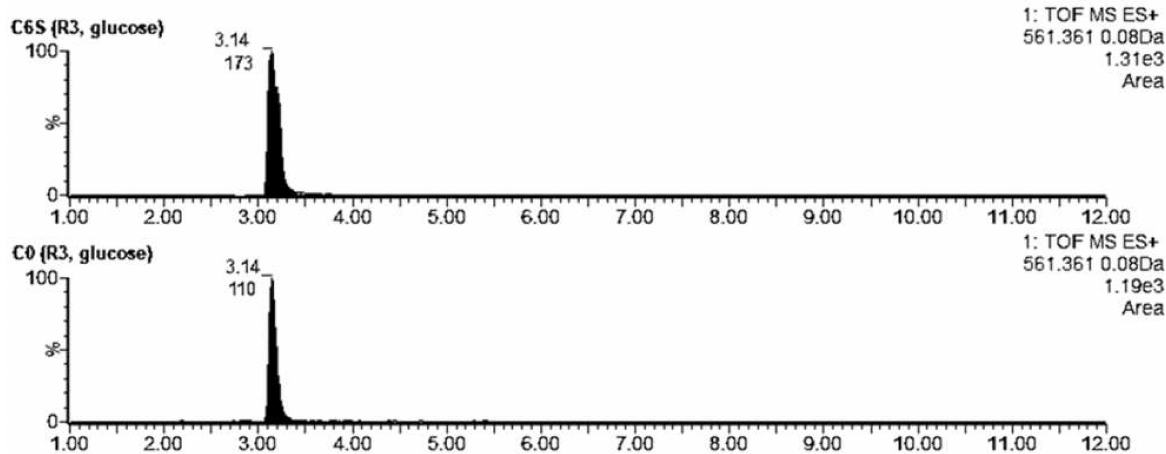
Figure 8. Extracted LC-MS chromatograms of desferrioxamine B produced by S. coelicolor C6S and C0 after 48 h of cultivation in R3